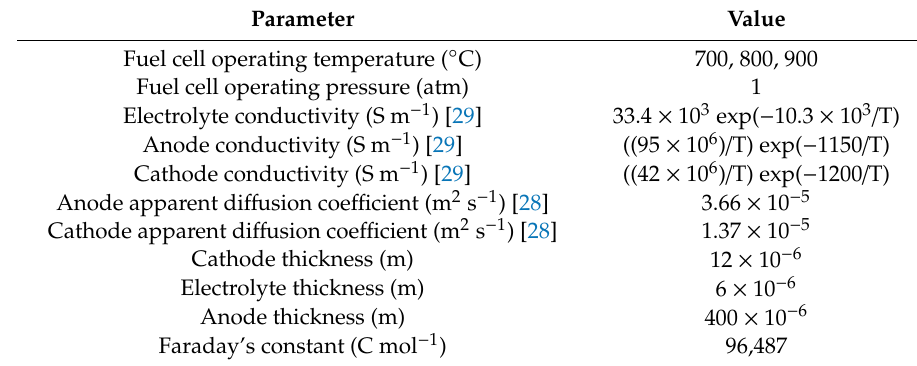
Table 1. Parameters for the numerical model of the solid oxide fuel